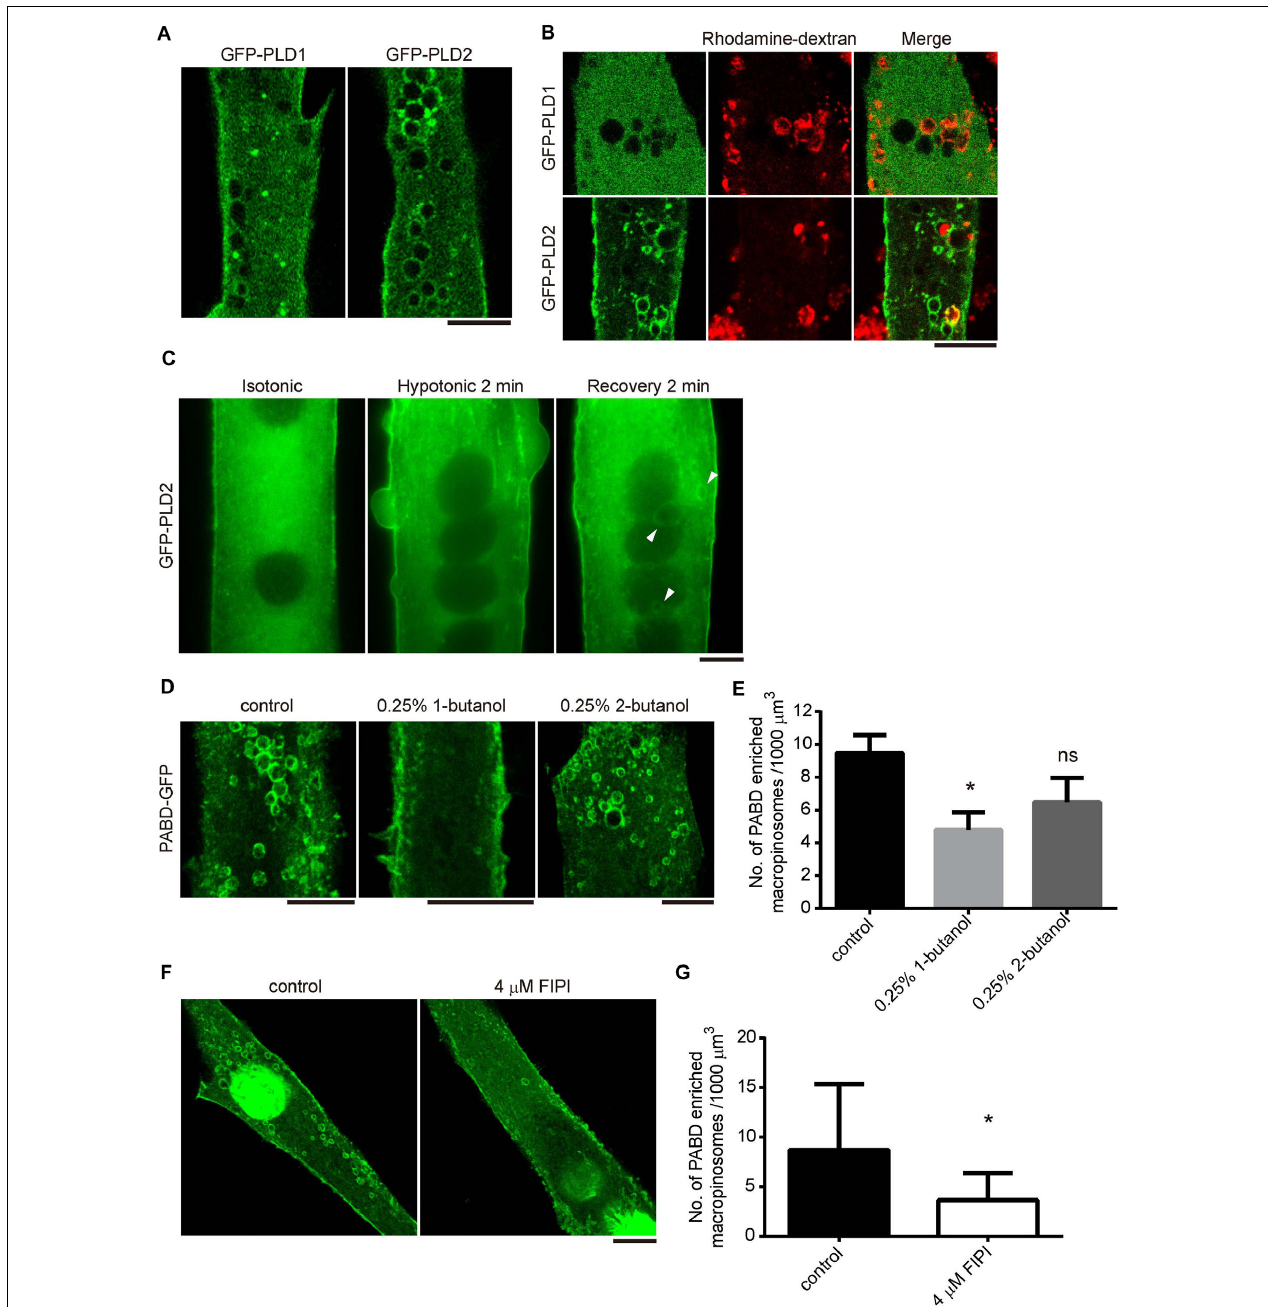
FIGURE 3 | PLD2 is enriched at the tension fluctuation-induced macropinosome. (A,B) Distribution of GFP-PLD1 and GFP-PLD2 in myotubes upon OS treatment. GFPP-PLD1 or GFP-PLD2 expressing myotubes were subjected to OS treatment with (B) or without (A) the presence of rhodamine-dextran. Images were acquired after intensive PBS wash and fixation. Confocal microscopy images were displayed. (C) Live cell imagining of GFP-PLD2 in myotube upon OS treatment. Arrowheads indicate GFP-PLD2 at the macropinosome. (D,E) The formation of PA-enriched macropinosome was inhibited by PLD inhibitor 1-butanol. PABD-GFP expressing myotubes were pretreated with 0.25% 1- or 2-butanol for 10 min and followed with OS treatment in the presence of indicated butanol (D) . The density of PA-rich macropinosome were quantified, compared with control cells and shown in (E) . (F,G) FIPI inhibited the formation of PA-enriched macropinosome formation. PABD-GFP expressing myotubes were pretreated with vehicle or 4 µ M FIPI in 1X PBS for 30 min and followed by OS treatment with or without 4 µ M FIPI. The density of PA-positive macropinosome was quantified, compared with control cells and shown in (G) . Ten myotubes for each condition were quantified. Data in (E,G) were analyzed with one-way ANOVA and Student’s t -test, respectively. Scale bars: 10 mm. ∗ p < 0.05.